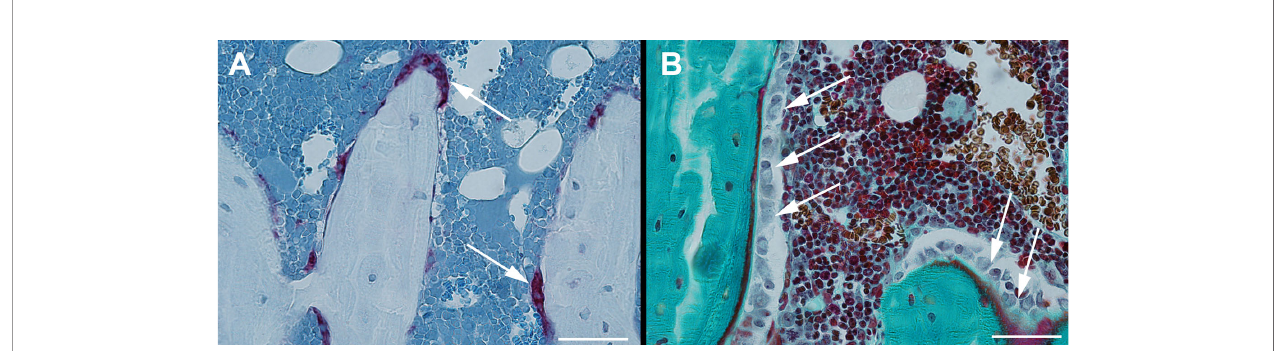
FIGURE 3 | Sagittal sections of the proximal tibia. Section stained for tartrate-resistant acid phosphatase (TRAP) and counterstained with aniline blue for osteoclast counting (A) and Masson-Goldner trichrome stained for osteoblast and osteoid counting (B) . Bar = 50 m m.